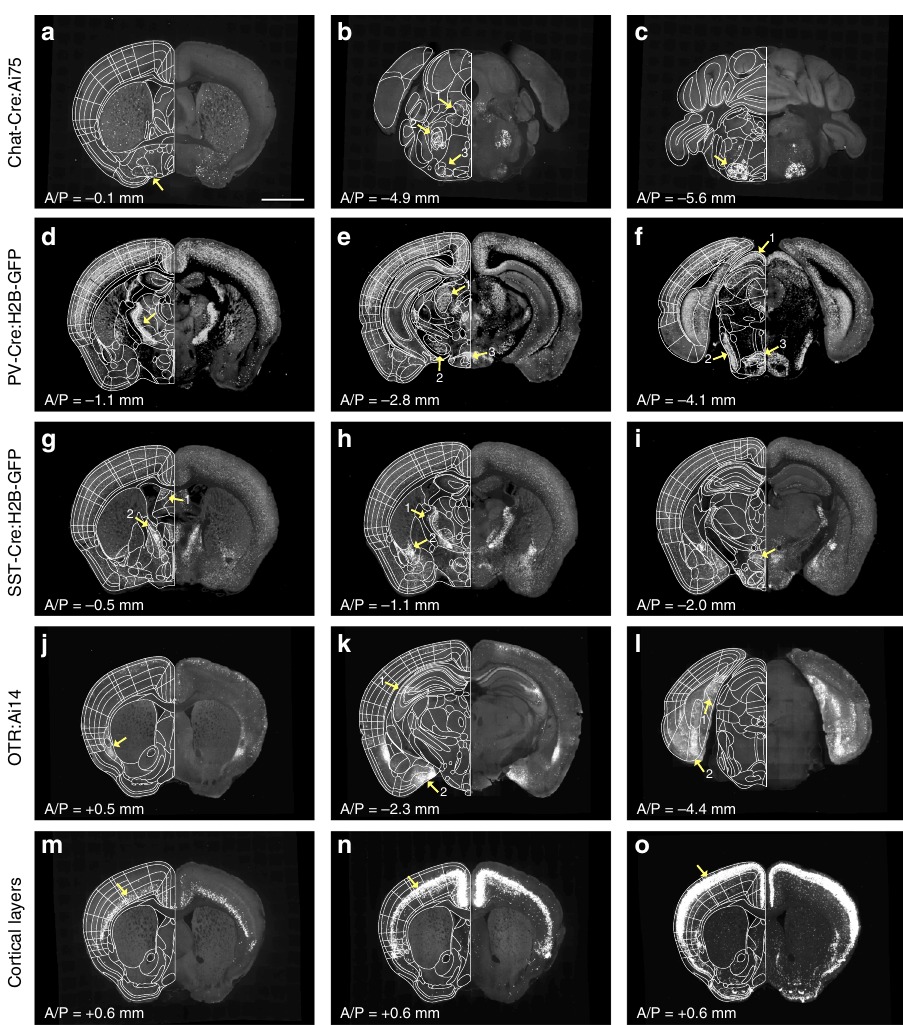
Fig. 2 Marker brains for further alignment of anatomical labels. a – o Examples of different marker brains registered to the Allen CCF that helped to align FP based labels in subregions as highlighted with yellow arrows. A/P represents Bregma anterior/posterior coordinates. a – c Chat-Cre:Ai75 brain to delineate ( a ) the basal forebrain structures including the nucleus of the horizontal limb of the diagonal band (arrow). It was also used to delineate ( b ) midbrain areas, including the laterodorsal tegmental nucleus (arrow1), the motor trigeminal nuclei (arrow 2), the lateral superior olive (arrow 3), and c the facial nucleus (arrow). d – f PV-Cre:H2B-GFP brain to delineate ( d ) the reticular nucleus (arrow), e the anterior pretectal nucleus (arrow 1), the substantia nigra, reticular part (arrow 2), and the retromamillary nucleus (arrow 3) as well as f the super fi cial gray layer superior colliculus (arrow 1), the ventral nucleus of the lateral lemniscus (arrow 2), and the reticulotegmental nucleus of the pons, pericentral part (arrow 3). g – i SST-Cre:H2B-GFP brain to delineate ( g ) the cerebral nuclei, such as the lateral septal nucleus, dorsal part (arrow 1) and the bed nuclei of the stria terminalis medial division posteromedial part (arrow 2), h the reticular nucleus (arrow 1) and the central amygdaloid nuclei (arrow 2), and i hypothalamic structures, such as the dorsomedial hypothalamic nuclei dorsal and ventral parts (arrow). j – l OTR:Ai14 brain to delineate ( j ) the dorsal endopiriform nucleus (arrow), k CA2 (arrow 1), the posteromedial cortical amygdala (arrow 2), and l the caudomedial entorhinal cortex (arrow1) as well as the postsubiculum (arrow 2). m – o Cortical layers de fi ned by m Ntsr-Cre:Ai75 for layer 6, n Rbp4-Cre:Ai75 for layer 5, and o Cux2-Cre:Ai75 for layer 2/3. Scale bar = 2 consists of several subdivisions that play various functions including the expression of fear behavior 39 . PAG, which is con- sidered a single structure in the CCFv3 labels, is further seg- mented into dorsomedial, lateral, dorsolateral, ventrolateral, pleoglial, and p1 divisions (DMPAG, LPAG, DLPAG, VLPAG, PlPAG, and p1PAG, respectively) in FP labels. Boundaries of the subdivisions were delineated by observing cell density differences between each division with SST-Cre expression (Fig. 5d). Ana- tomical connectivity data also showed that these subdivisions receive topographically distinct inputs from other brain regions (Supplementary Fig. 5). Each subdivided region was given a unique numerical ID and assigned within its parent structures (Fig. 5e, f).